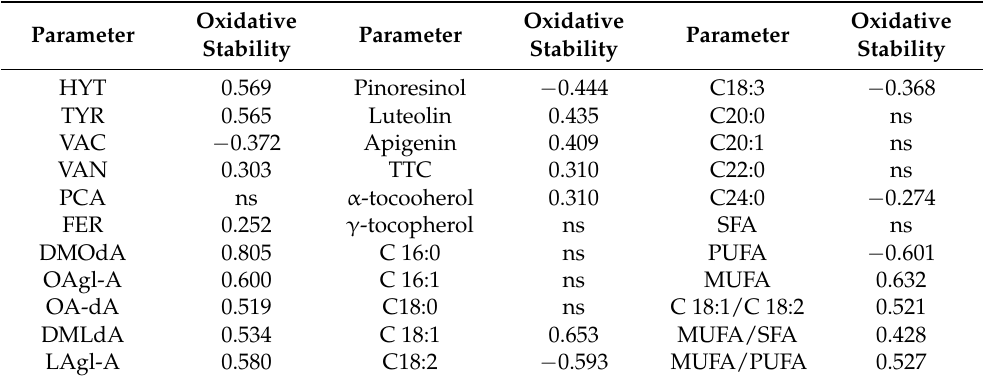
Table 5. Correlation factors between phenolic compounds, tocopherols and fatty acids and oxidative stability of virgin olive